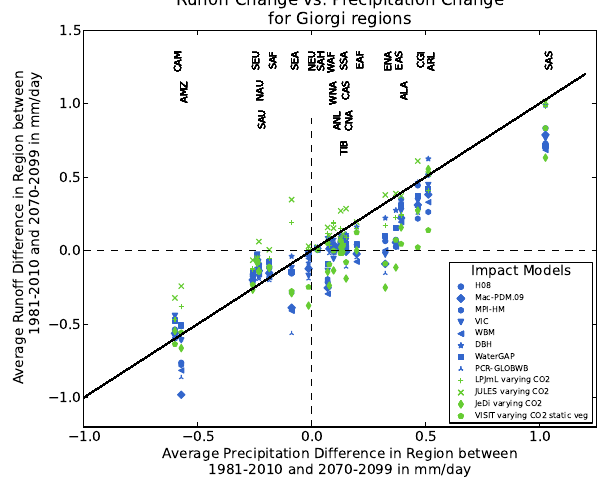
Fig.3. Scatterplotofprecipitationchangeagainstrunoffchangebetween1981-2010and2070-2099inmmday-1fortheGiorgiregions– includingresultsfromallmodelsforcedwithHadGEM2-ESRCP8.5climate. Solid1:1line. Dashedx=0lineandy=0line.